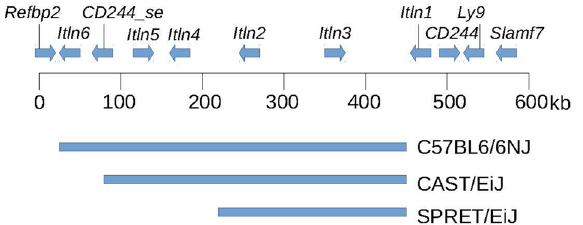
Figure 6. Deletions found by sequence analysis of laboratory strain mice. The region covered by the original 129S7/Sv contig is shown with genes annotated. Extent of deletions found by sequence read depth analysis in laboratory strain mice shown below the size scale.